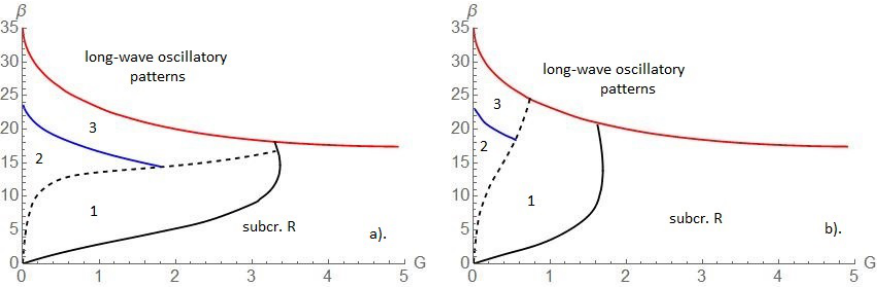
Figure 6. Stability maps for N = 10 − 8 ( a ) and N = 10 − 7 ( b ). Other parameters L = 0.003 and S = 1. Regions “1”, “2”, and “3” correspond to the same named in Figure 5.